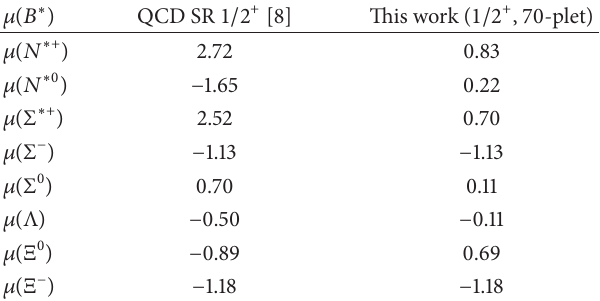
Table 1: Magnetic moments of 56 -plet and 70 -plet